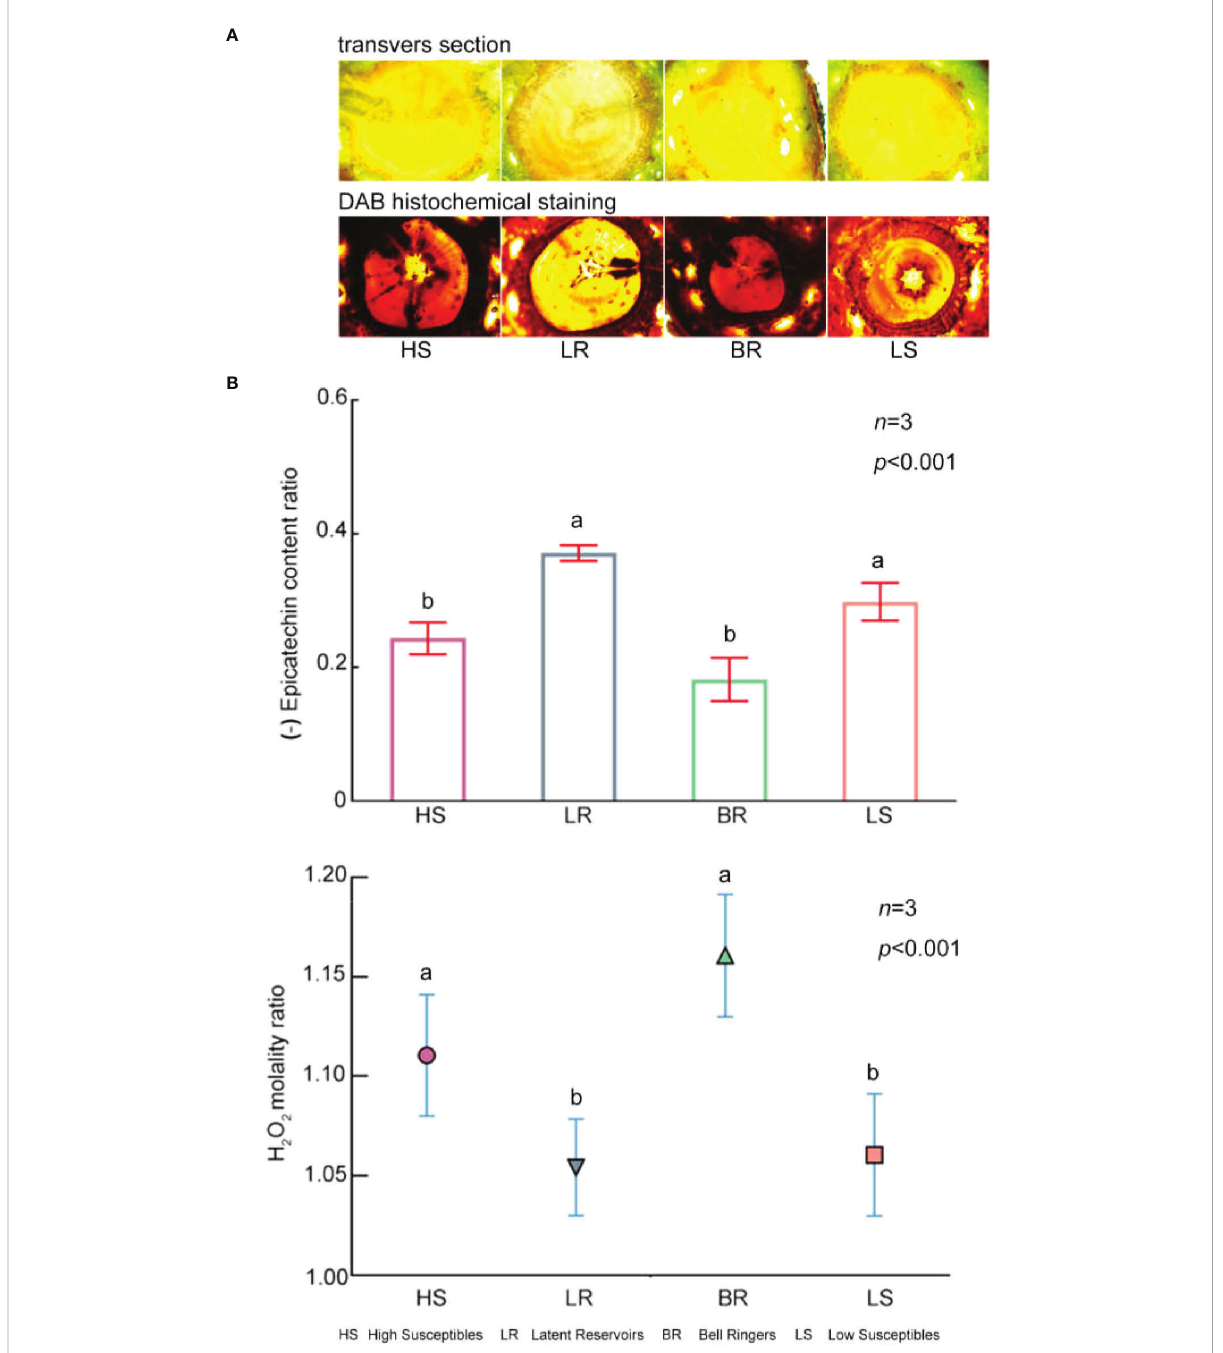
FIGURE 6 Contents of EC and H 2 O 2 in 4 types of P. koraiensis . (A) Changes in H 2 O 2 levels in 4 types of P. koraiensis , as revealed by DAB histochemical staining at 12 hpi. (B) H 2 O 2 molality ratio and EC content ratio in the 4 types of P. koraiensis at 12 hpi. (The histogram represents the EC content ratio, and the scatter plots with different shapes represent the H 2 O 2 molality ratio). Data in (B) were analyzed by one-way ANOVA followed by Tukey ’ s posthoc test, with different letters indicating statistically signi fi cant differences at 95% con fi dence. The data in the fi gures are means ± SE ( n =3). Letter a: the maximum average number marked with the letter a Letter b: The maximum average is compared with the following averages. Where the difference is not signi fi cant, the letter a is marked until a signi fi cant difference is marked with the letter b Letter labeling followed by analogy. Where there is an identically marked letter, the difference is not signi fi cant; where there are different marked letters, the difference is signi fi